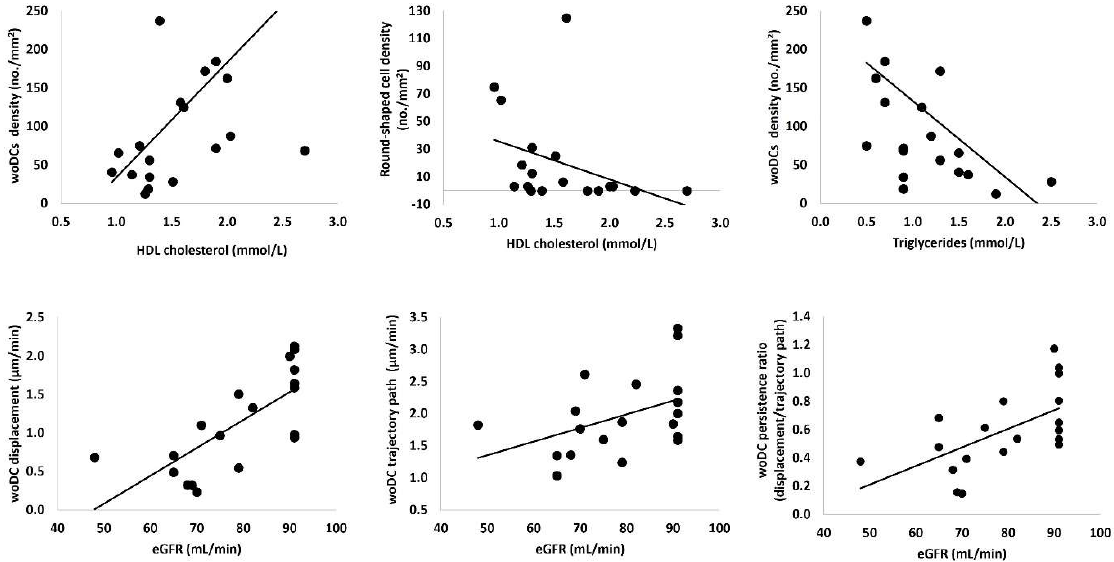
Figure 3. Relationship between corneal immune cell parameters and biochemistry measures in type 1 diabetes. woDCs; dendritic cells without visible dendrites, HDL; high-density lipoprotein, eCFR; estimated glomerular filtration rate.